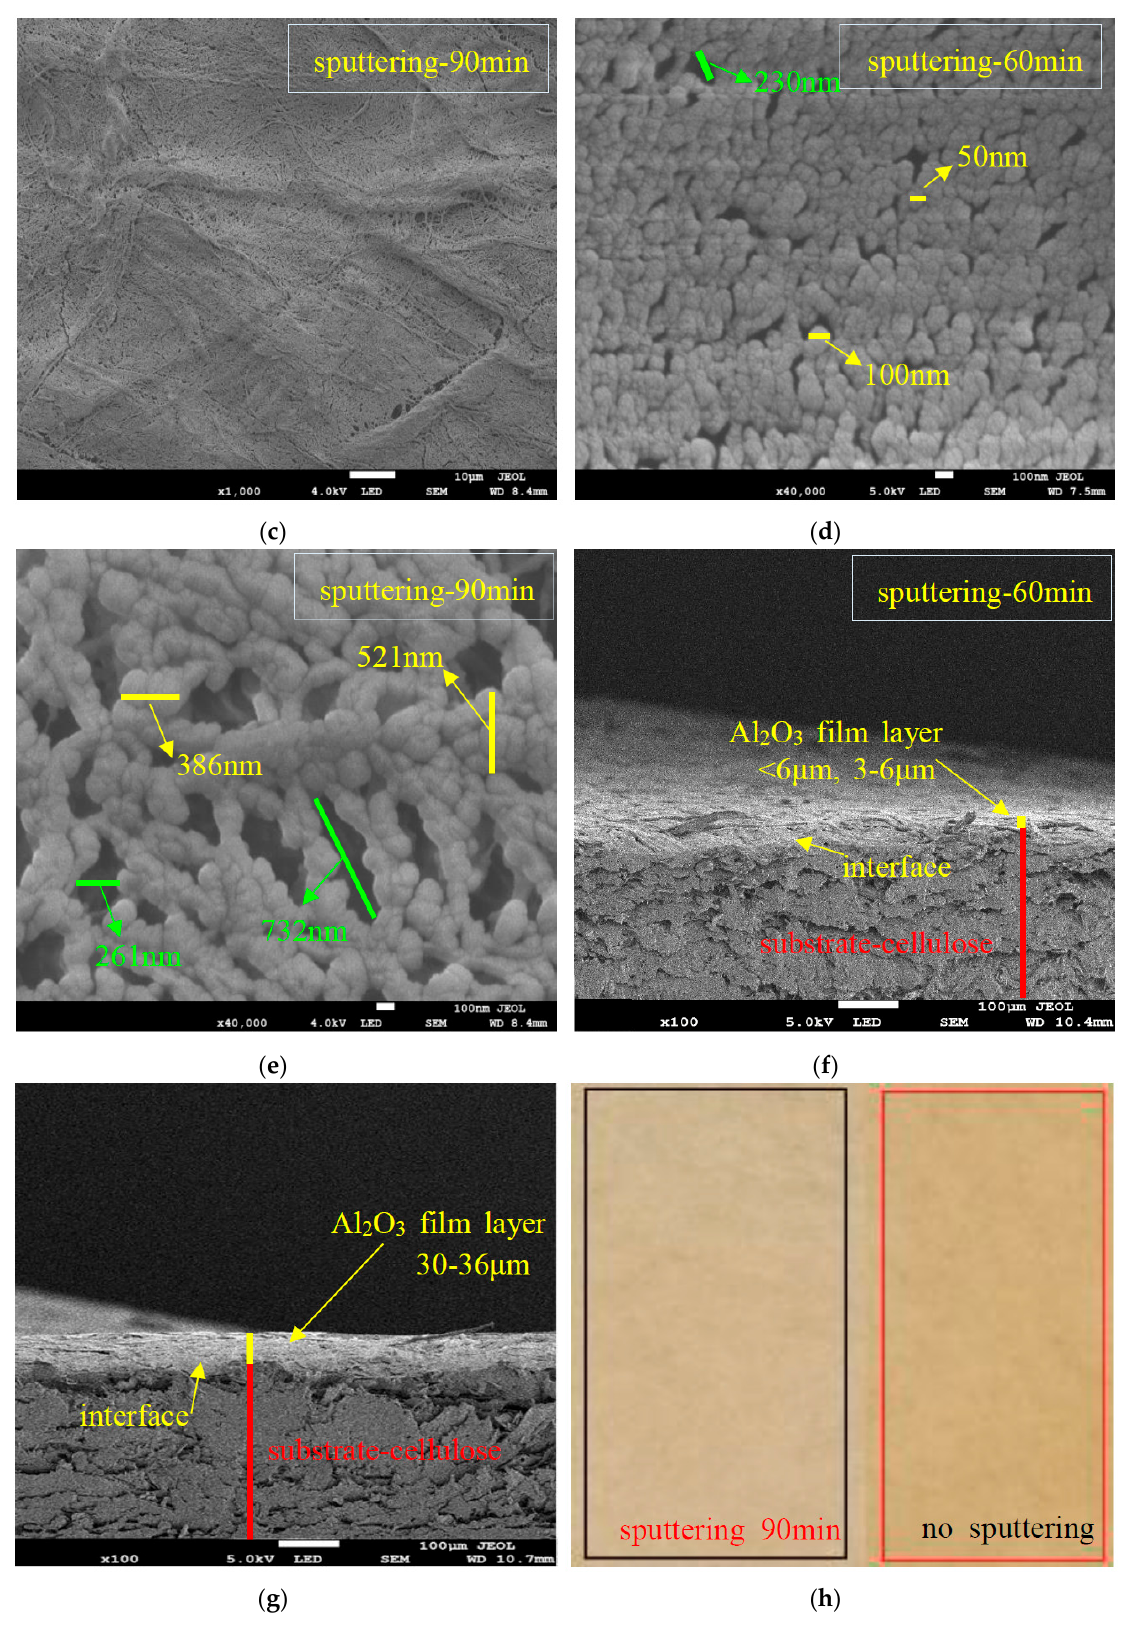
Figure 3. Scanning electron microscopy (SEM) images of the fresh pressboard surface at 1000× ( a ); pressboard surface prepared by reactive RF magnetron sputtering of Al target for 60 min at 1000× ( b ); 90 min at 1000× ( c ); 60 min at 40,000× ( d ); 90 min at 40,000× ( e ); the side elevation appearance of pressboard sputtered 60 min at 100× ( f ) and 90 min at 100× ( g ); the sputtered and fresh samples ( h ).